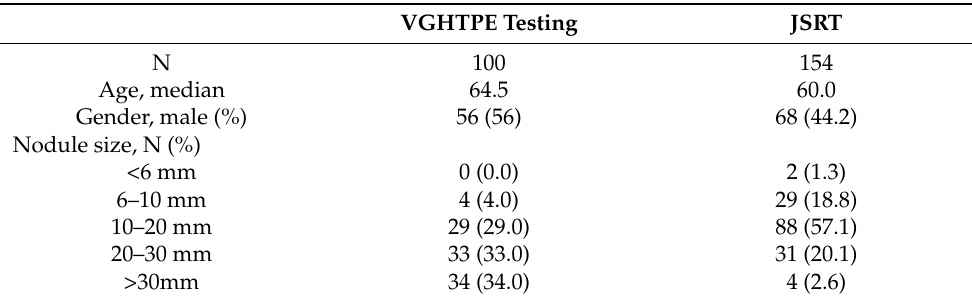
Table 3. Characteristics of the VGHTPE testing dataset and JSRT dataset.